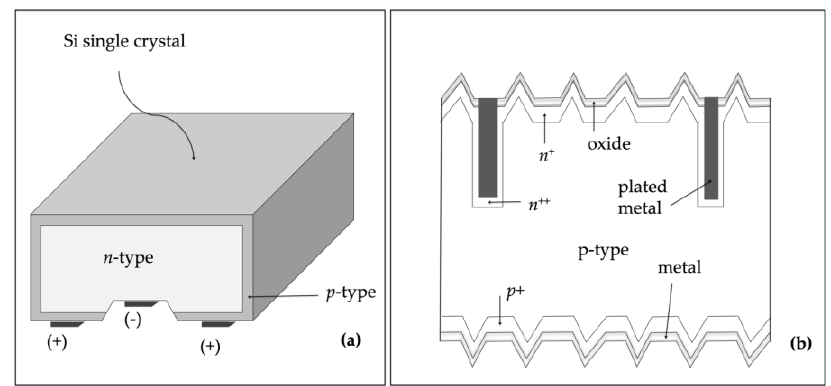
Figure 1. ( a ) first modern silicon cell, reported in 1954 [12], fabricated on single-crystalline silicon wafers with the pn junction formed by dopant diffusion. ( b ) Passivated Emitter Rear Locally-diffused (PERL) silicon cell, with light trapping, back-reflector and burried contacts, which took efficiency close to 27%.